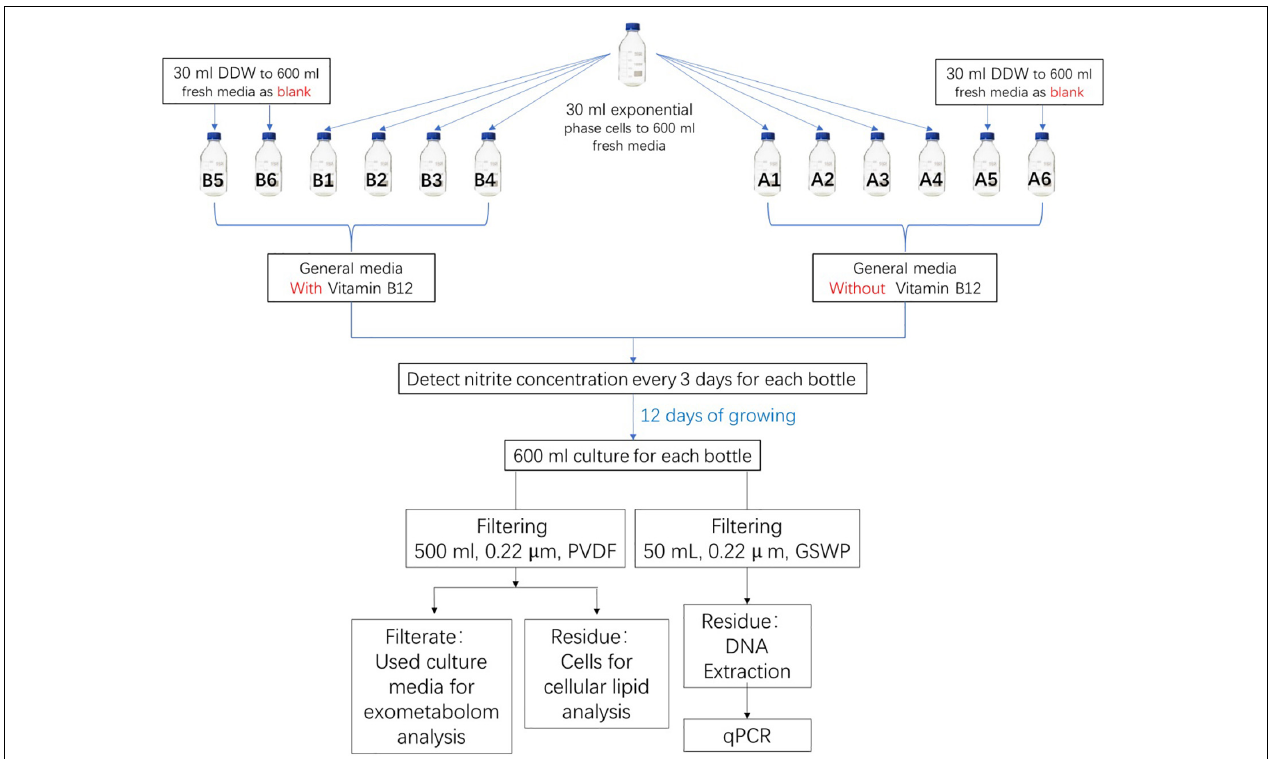
FIGURE 1 | Experimental design for metabolite analysis of N. maritimus SCM1. One group of the cultures was prepared with a supplement of vitamin B 12 and the other group without. Cell growth was monitored by nitrite concentration in the medium. After 15 days of culture, cells were harvested by filtering 500 ml of culture solution. The used and filtered culture medium was also collected, and the organic compounds in the medium were extracted with SPE. The other 50 ml of culture medium was used for qPCR analysis.